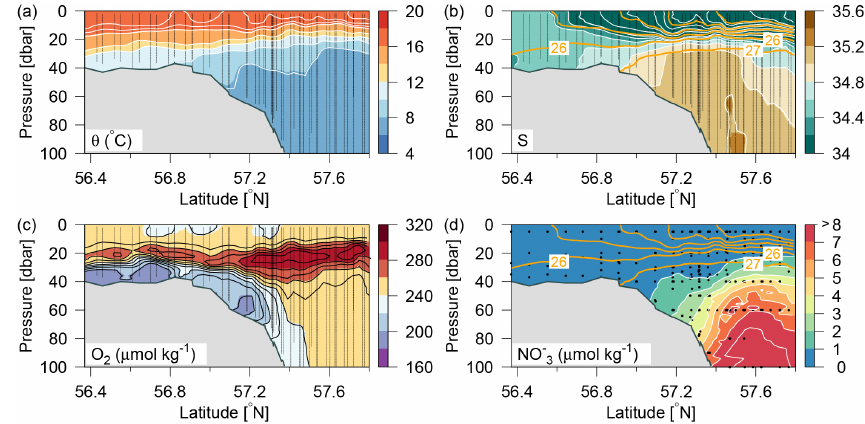
Figure 2. Distributions along Tr4 of (a) potential temperature ( ◦ C; colours and white contours, additional contours above 16 ◦ C at 0.5 ◦ C intervals), (b) salinity (psu; colours and white contours, additional contours between 26 and 34 at 0.5psu intervals) and contours of potential density anomalies (intervals of 1kgm − 3 ; orange lines), (c) oxygen (µmolkg − 1 ; colours and black contours), and (d) nitrate (µmolkg − 1 ; colours and white contours and orange contours of potential density anomalies as in (b) . Vertical lines show location of the CTD measure-